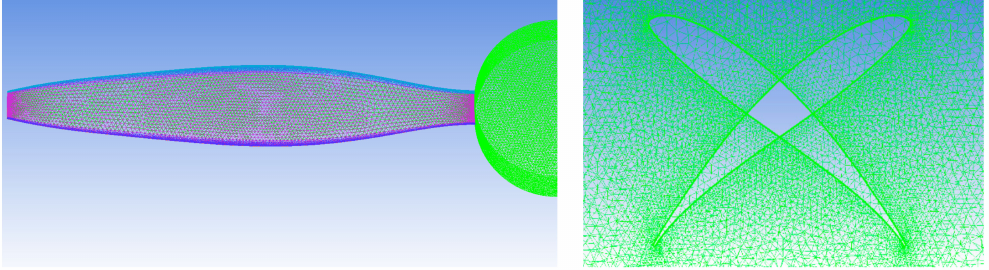
Figure 5. Mesh near the propeller.